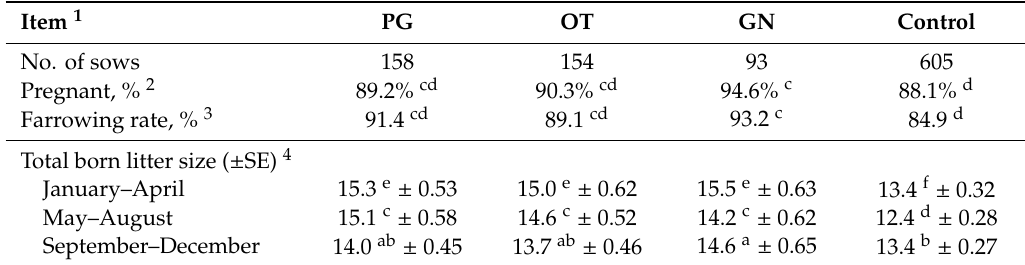
Table 1. E ff ect of seminal additives on fertility of multiparous sows throughout the year. Sows were assigned by parity to insemination of semen doses containing either 87 µ g of cloprostenol (PG), 5 IU oxytocin (OT), 2 µ g buserelin (GN), or serve as non-treated